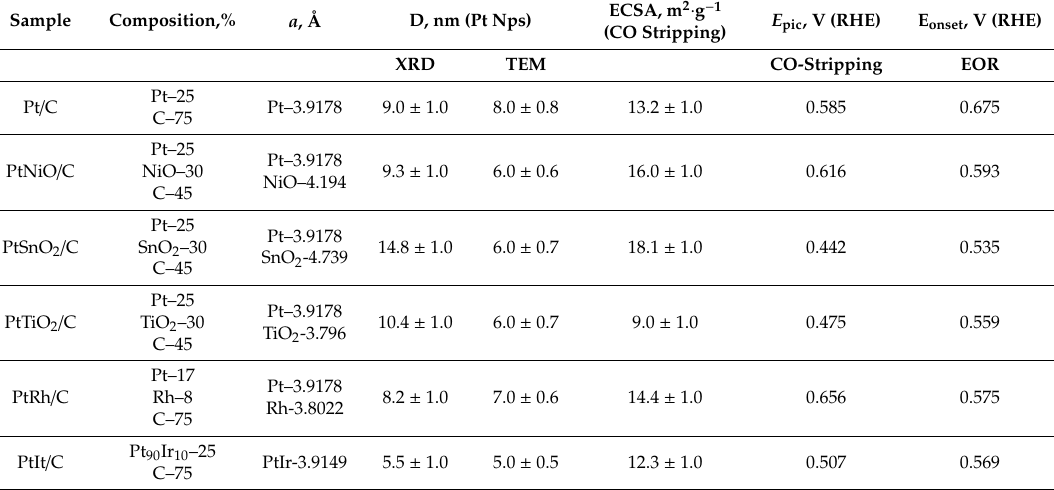
Table 1. Characteristics of Pt / C, PtNiO / C, PtSnO 2 / C, PtTiO 2 / C, PtRh / C, and PtIr / C